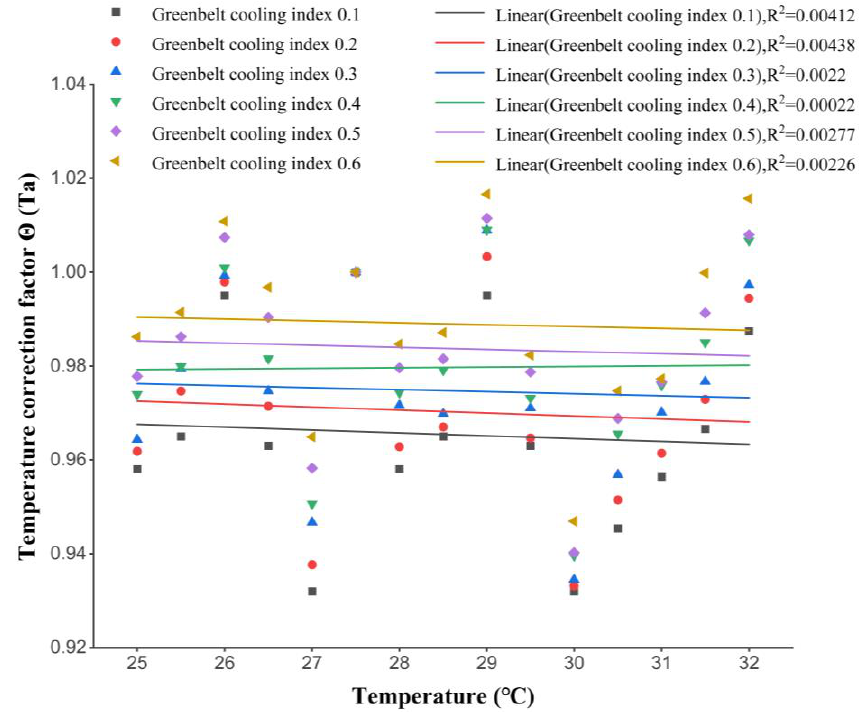
Figure 9. Influence of air temperature on cooling effects of green space.